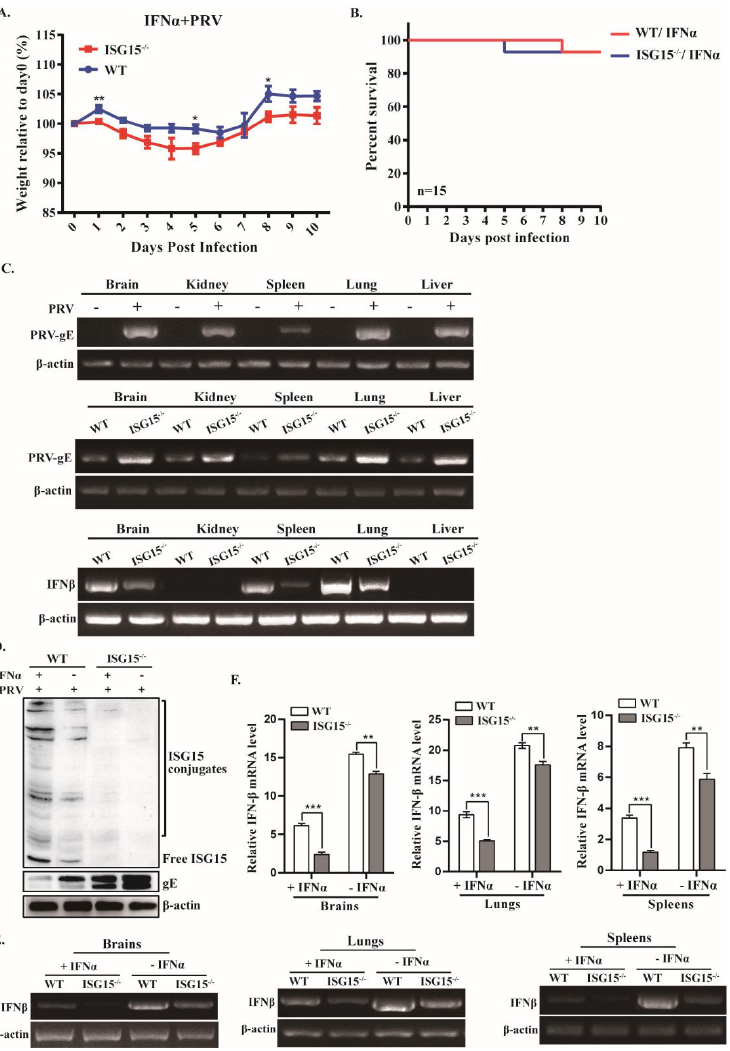
Figure 3. Expression of IFN β is reduced in ISG15 -/- mice after PRV infection. ( A , B ) Body weight and survival rate of infected WT and ISG15 -/- mice with IFN α treatment were monitored for 10 days. ( C ) WT and ISG15 -/- mice were infected intraperitoneally with PRV for 4 days, followed by PCR for detection of viral DNA levels in the indicated tissues from infected mice and RT-PCR for detection of IFNβ levels in indicated organs of WT and ISG15 -/- mice ( C ). ( D ) The protein expres- sion of ISG15 and PRV-gE in brains of WT and ISG15 -/- mice were analyzed by Western blotting. ( E , F ) IFNβ levels in the indicated tissues of infected mice were examined by RT -PCR ( E ) and RT- qPCR ( F ). The average results from three independent experiments are plotted. * p < 0.05; ** p < 0.01; *** p < 0.001.